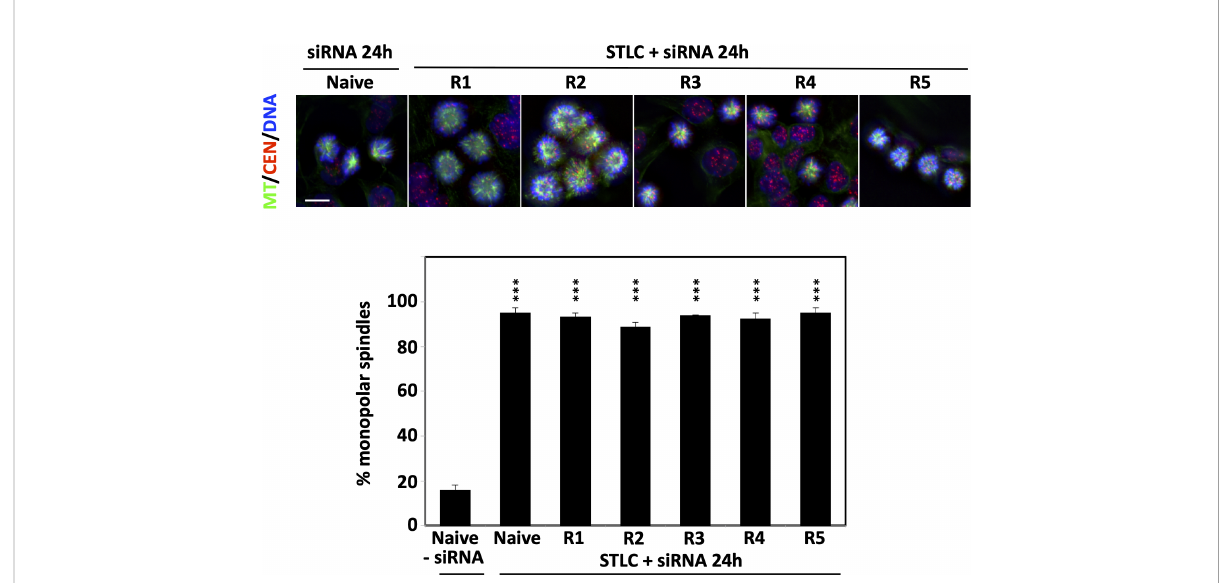
FIGURE 2 STLC resistant clones require the presence of Eg5 for growth in the presence of STLC. Immuno fl uorescence microscopy images of mitotic cells from unselected naive HCT116 cells and selected HCT116 STLC-resistant cells that were subjected to Eg5 siRNA mediated depletion of Eg5. Spindle microtubules were detected with an anti-tubulin antibody (green), centromeres with an auto-immune antibody (red) and chromatin with DAPI (blue). Scale bar in the images corresponds to 10 m m. The % of monopolar spindles following RNAi mediated Eg5 depletion in the presence of STLC was calculated for each the cell lines. Asterisks indicate signi fi cance values; *** p <